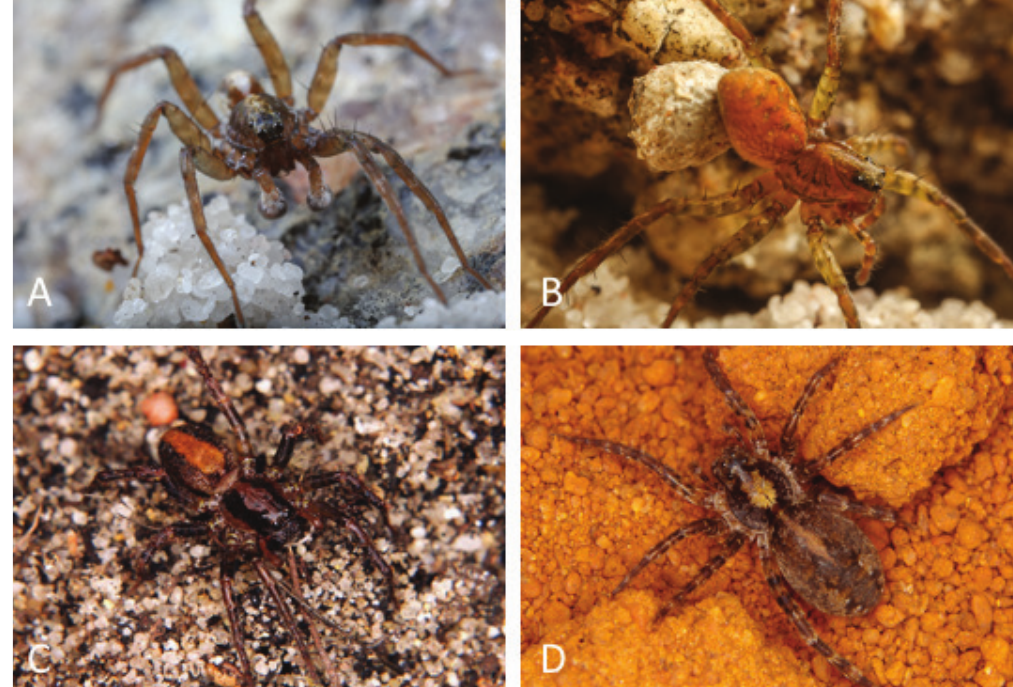
Figure 1. Life images of Artoria species. A , A. mckayi Framenau, 2002 (male from Avon River, Victoria); B , A. mckayi (female with eggsac from Avon River, Victoria); C , A. flavimana Simon, 1909 (female from Capel, Western Australia); D , A. taeniifera Simon, 1909 (female from Ravensthorpe, Western Australia). All species occur in New South Wales; A. mckayi has also been found in the Australian Capital